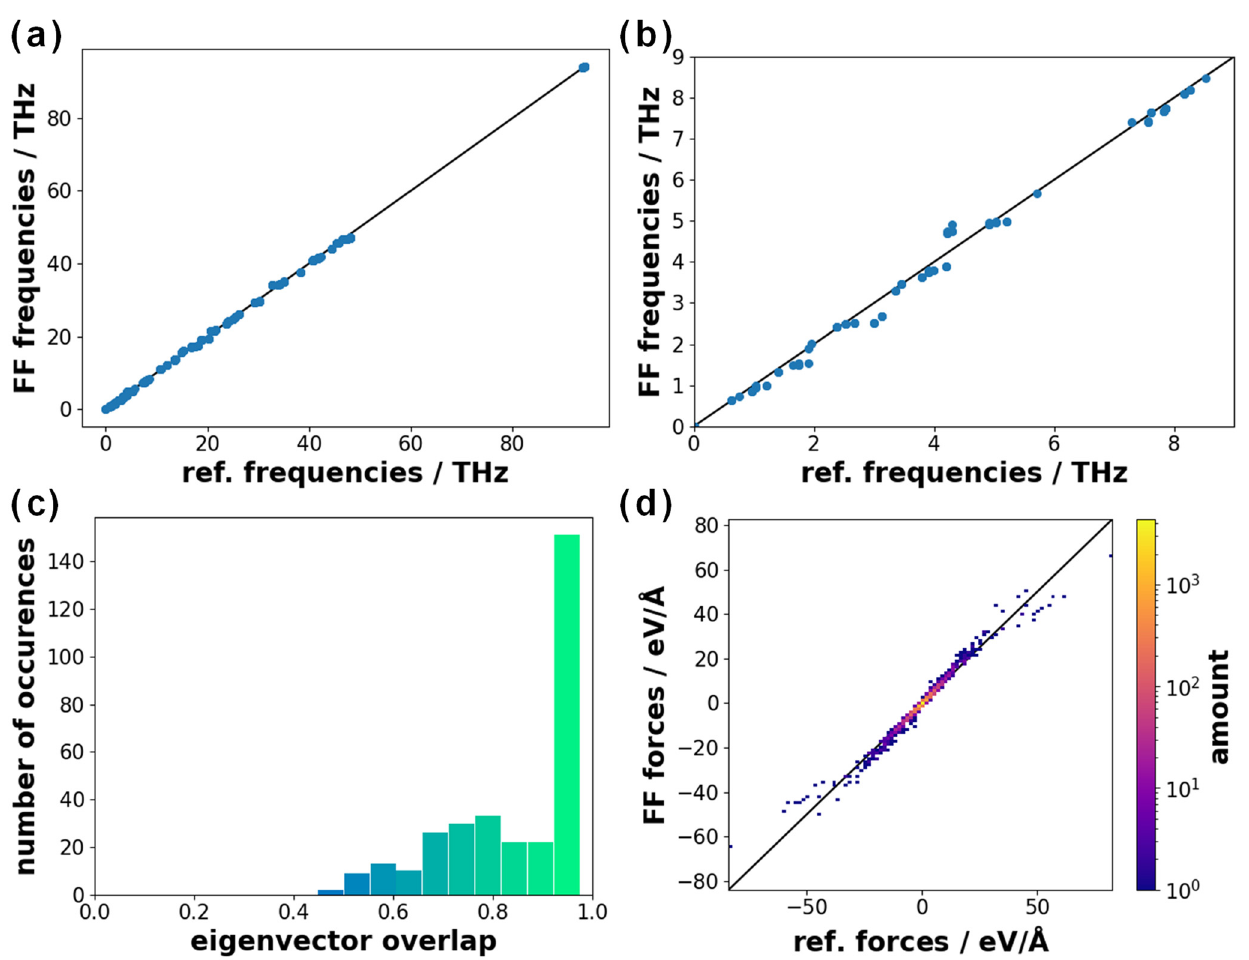
Figure 3. Overview of the performance of the force field for IRMOF-1 compared to the DFT reference for various observables: comparison of vibrational frequencies at Γ for ( a ) the entire frequency range and ( b ) for the low-frequency modes below 9 THz; ( c ) histogram showing the dot product overlap of eigenvectors at Γ ; ( d ) 2D Histogram with a 100 × 100 bin grid comparing the Cartesian forces on all atoms for a set of 30 randomly displaced geometries.